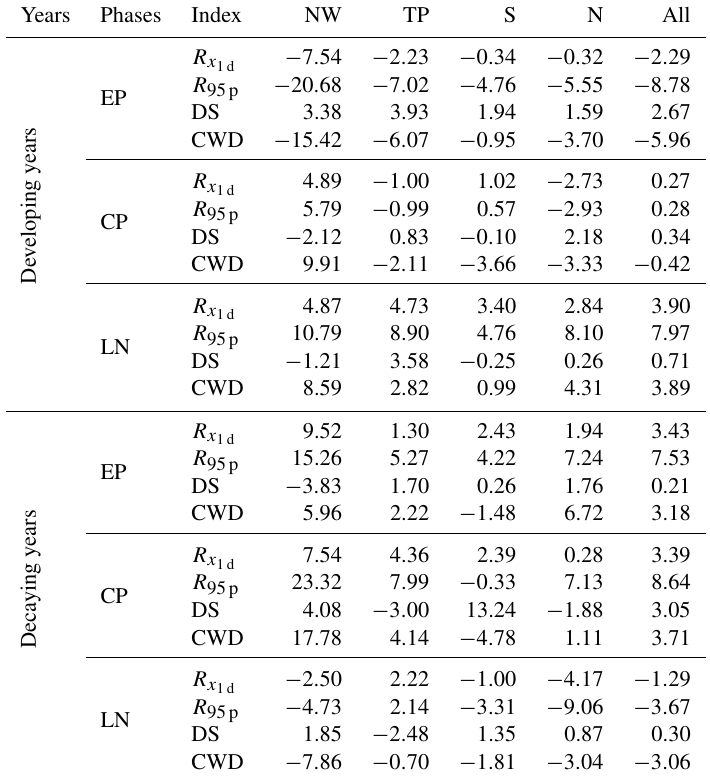
Table 3. Average anomalies of precipitation extremes during EP, CP, and LN phases (%). Years Phases Index NW